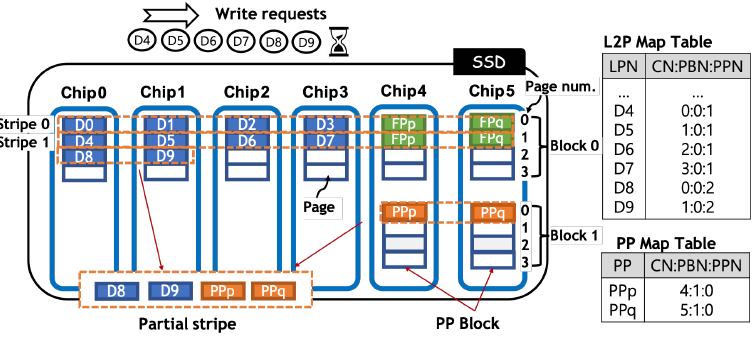
Figure 4. Example of writing partial stripe parity of mSAPL